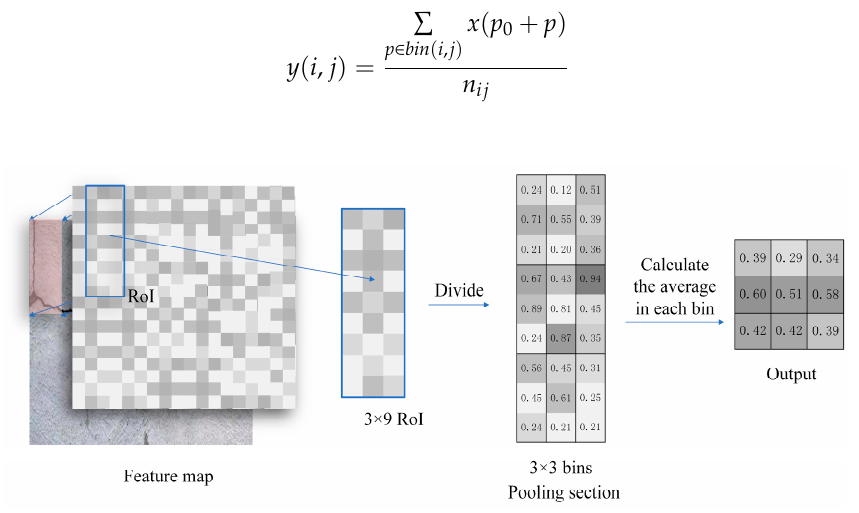
Figure 7. Example of a 3 × 3 regular average RoI pooling.